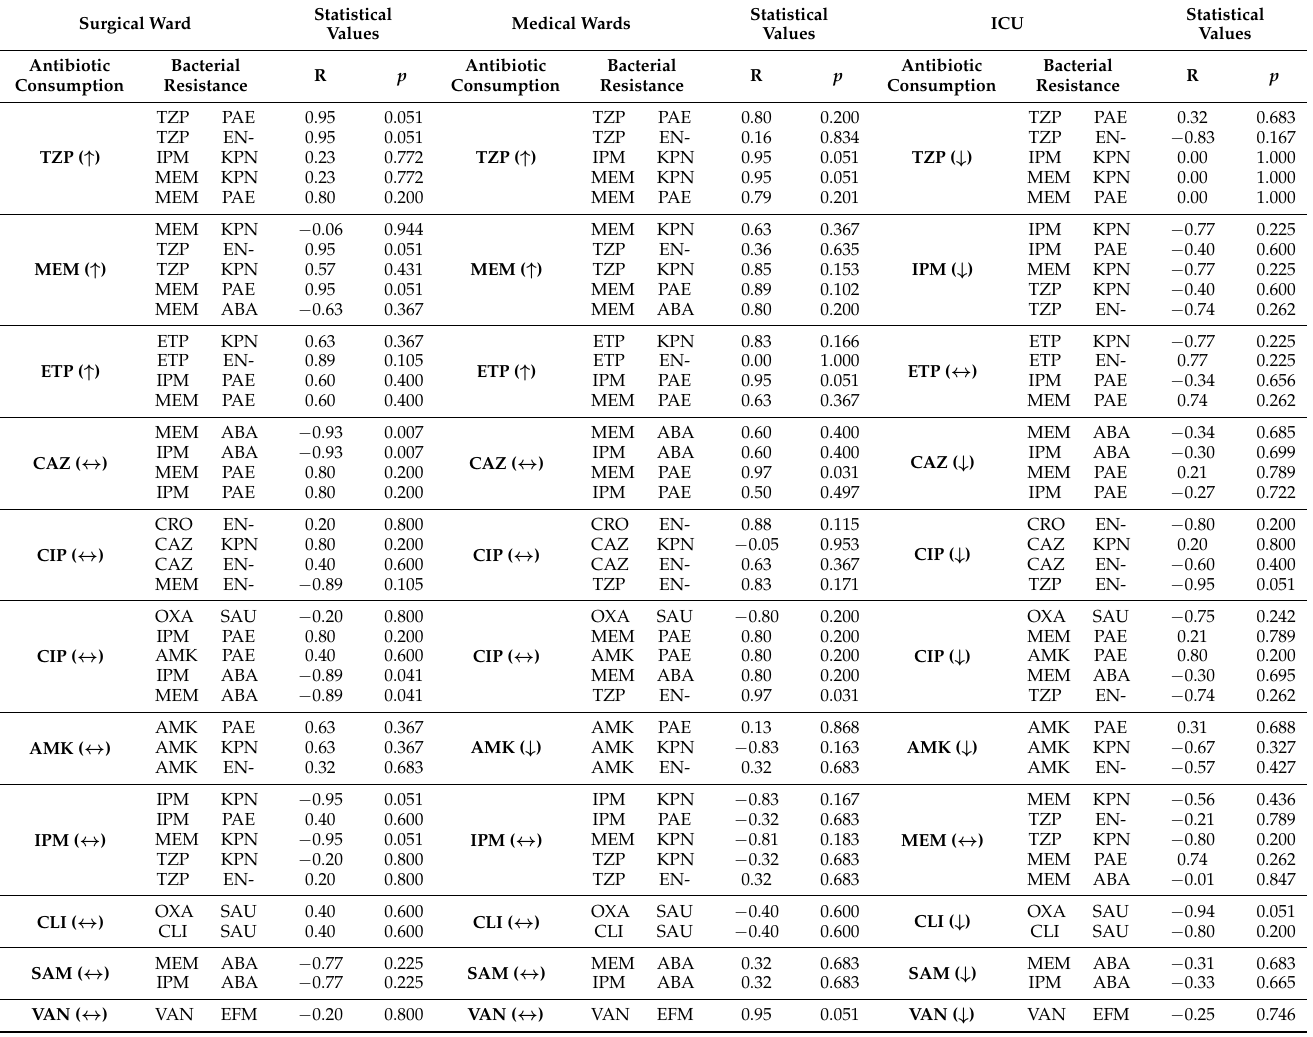
Table 1. Results of the Spearman correlation demonstrating the relationship between the frequency of strains resistant to a particular antimicrobial and the consumption of antimicrobials that potentially exert selection pressure divided by services. Surgical Ward Statistical Values Medical Wards Statistical Values ICU Statistical Values Antibiotic Bacterial Antibiotic Bacterial Antibiotic Consumption Resistance Consumption Resistance